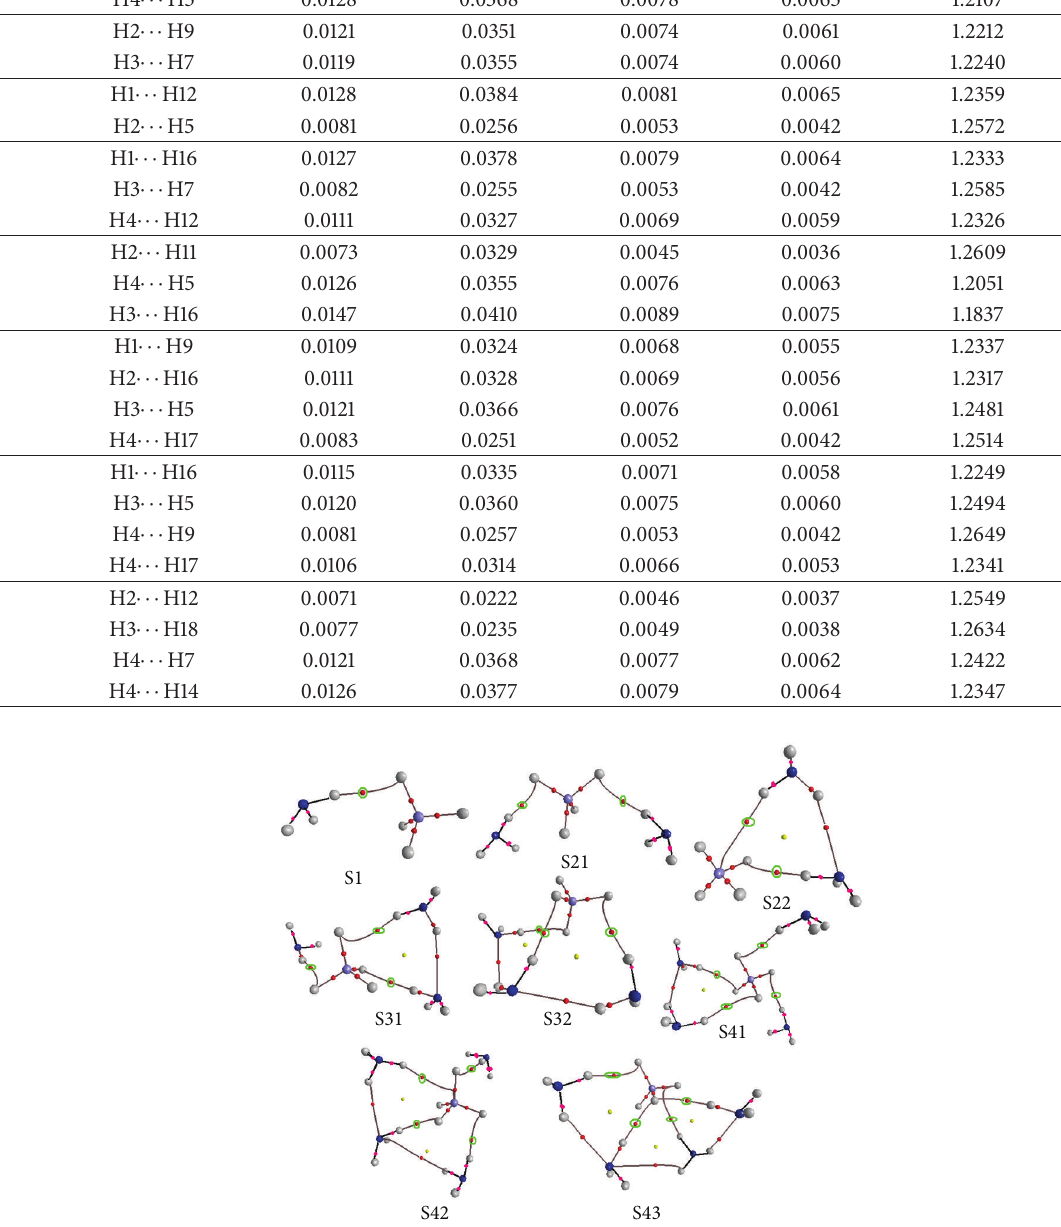
Table 6: Topological parameters for optimized clusters at MP2/6-311++G(d,p). Cluster